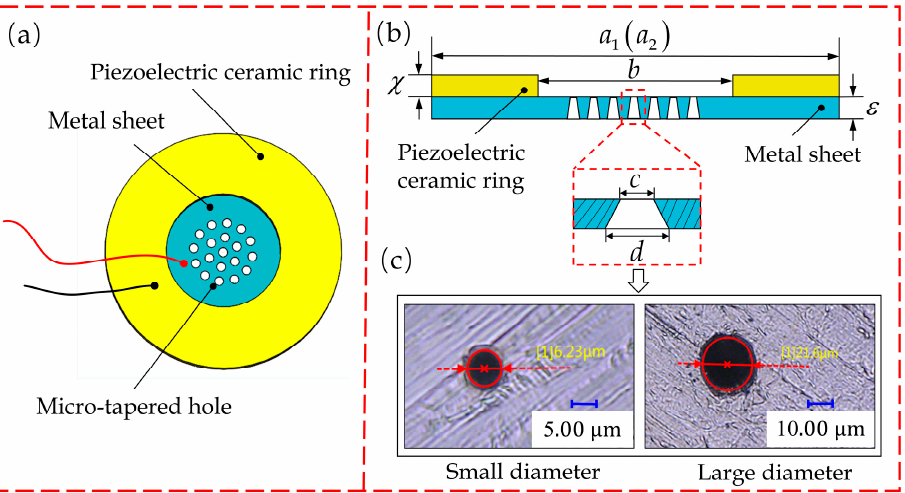
Figure 1. Structural drawing of atomizing sheet: ( a ) vertical view; ( b ) side view; ( c ) microscopical photographs of the small end and large end of a micro-tapered hole. Table 1. Atomizing sheet structure parameter table.